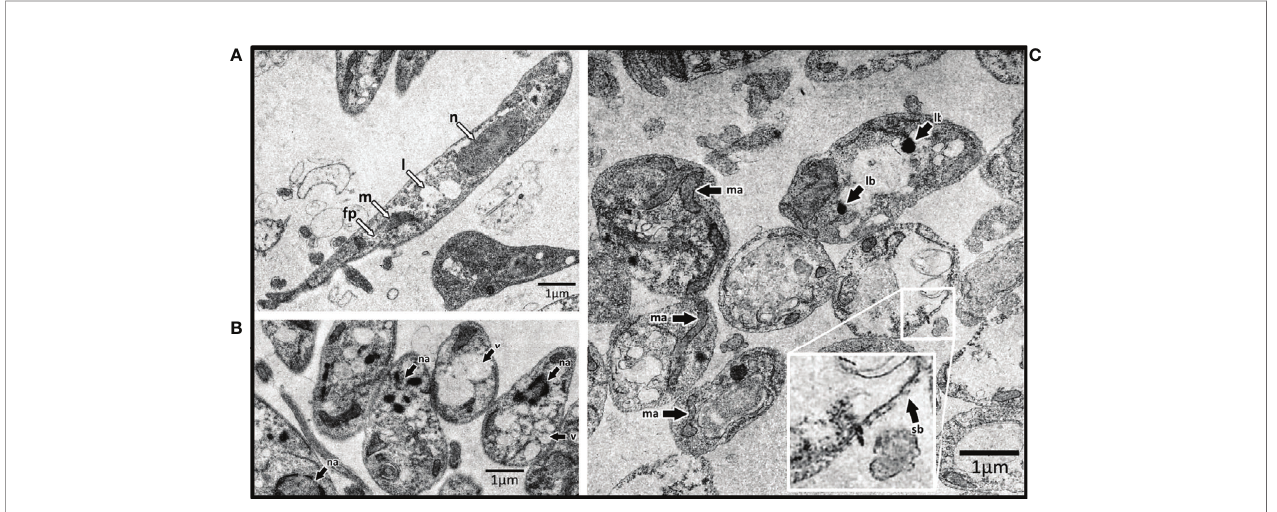
FIGURE 4 | Transmission electron microscopy of L. amaz /tc3 promastigotes. (A) Untreated culture with normal cellular structures: nucleus (n), lipid inclusion (l), mitochondrion (m), and fl agellar pocket (fp). Black arrows indicate ultrastructural alterations in parasites exposed to EGCG (B) and GAL (C) nuclear alterations (na), vacuolization (v), alterations in mitochondrial structure (ma), lipid-storage bodies (lb), and surface blebbing